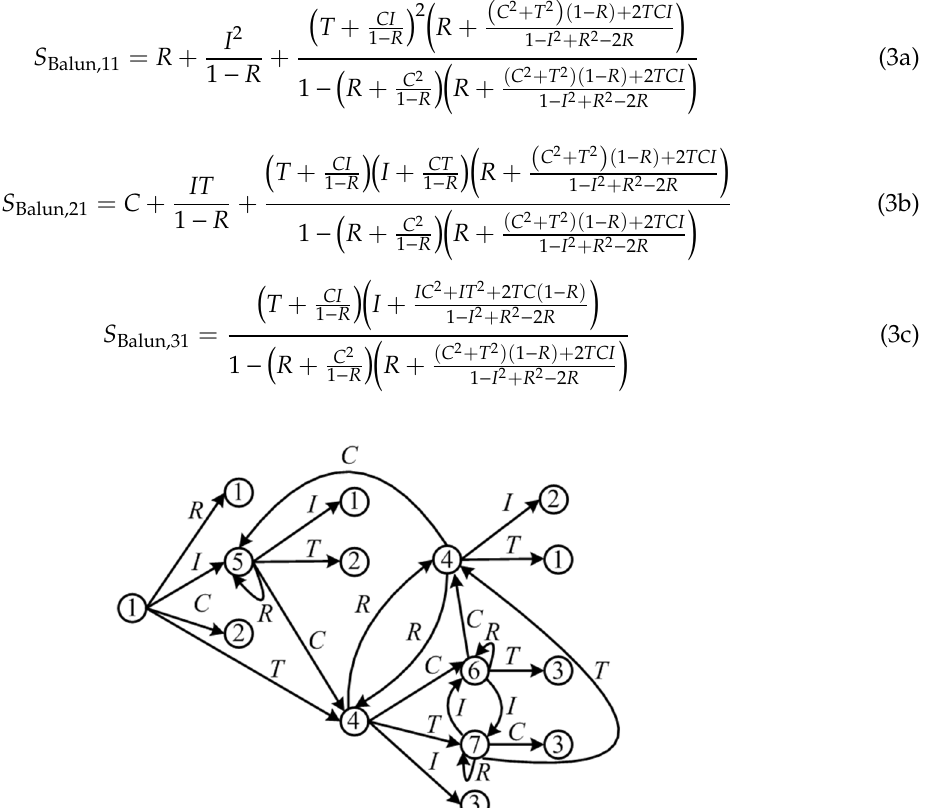
Figure 3. Signal flow analysis of the proposed tunable balun at port 1.